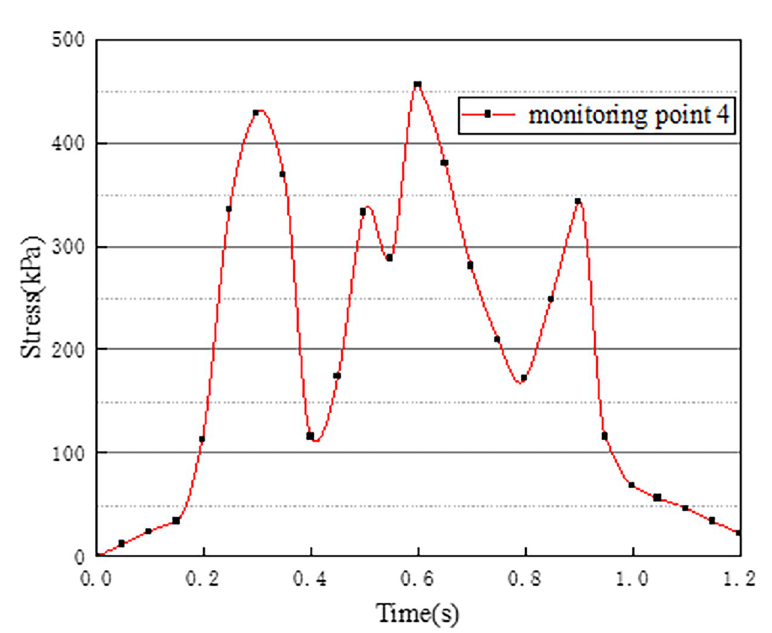
Fig 10. Stress time history curve of monitoring point 4.